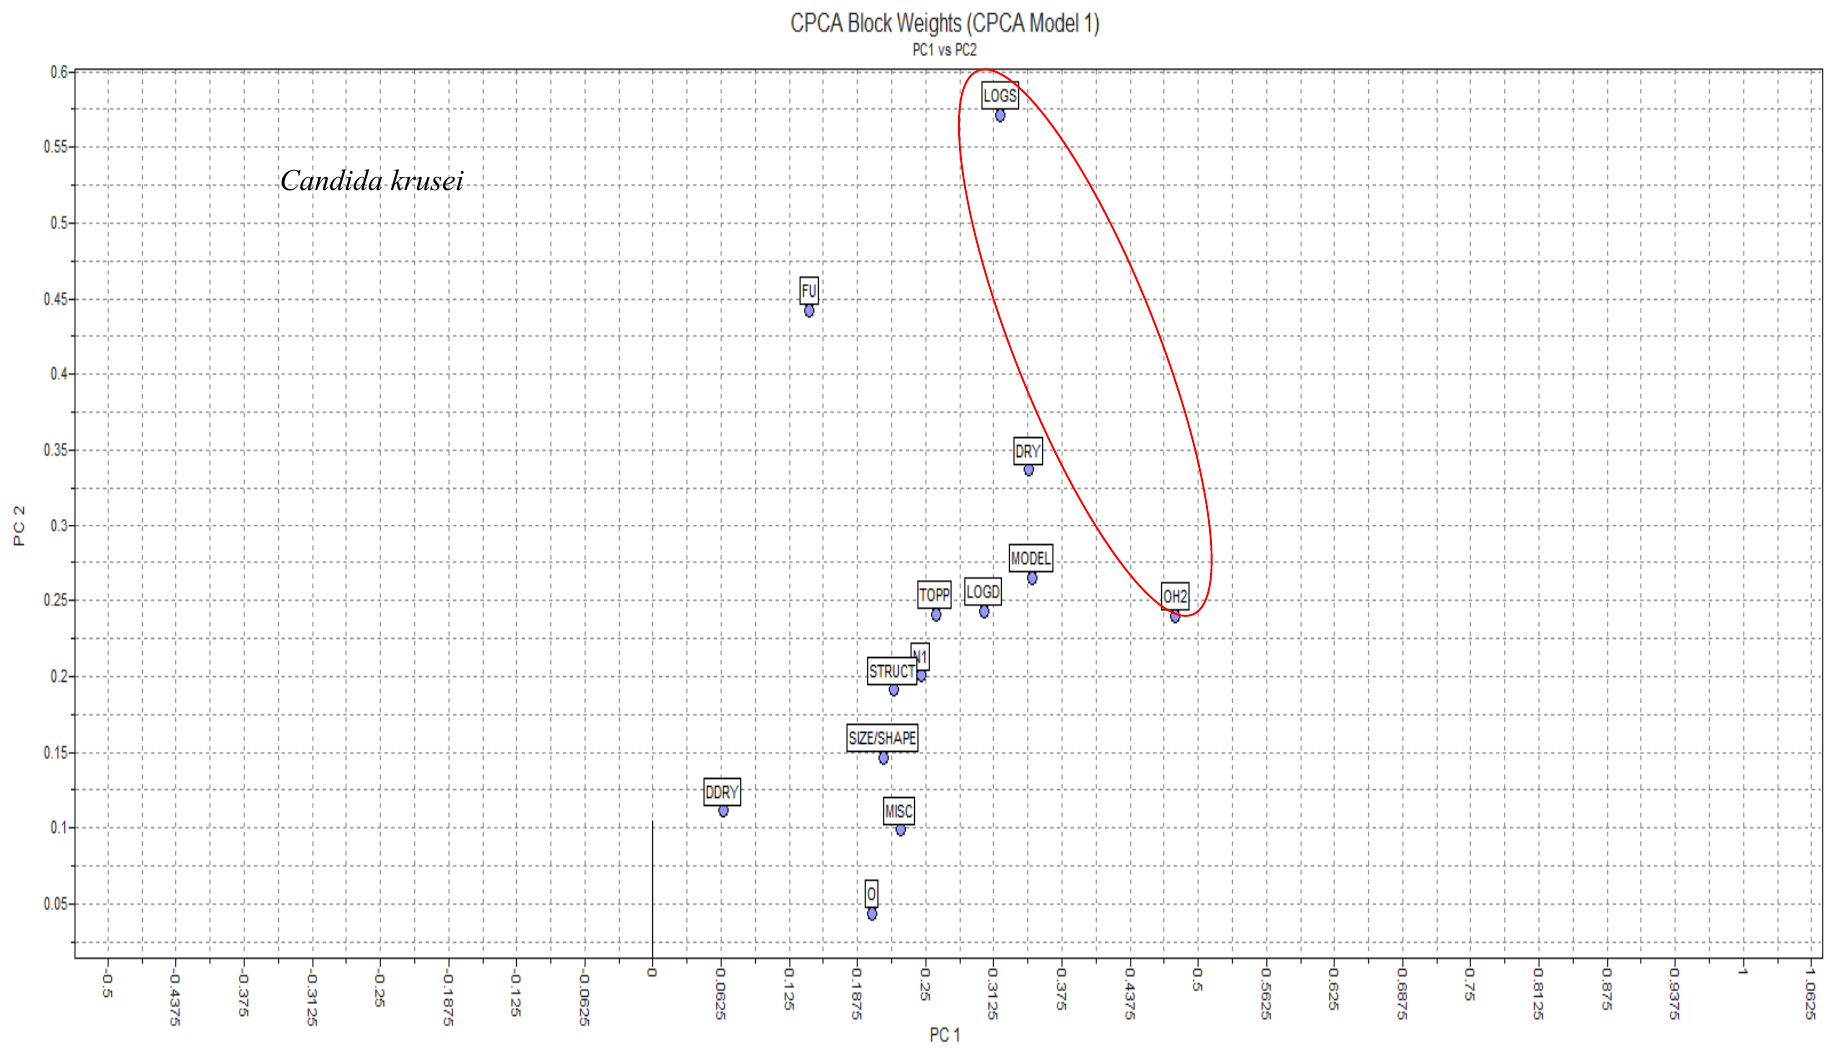
Figure 4. The relationship between the weights of the blocks of descriptors and the PC1 and PC2 components of the CPCA calculated using activities against C. krusei and C. neoformans